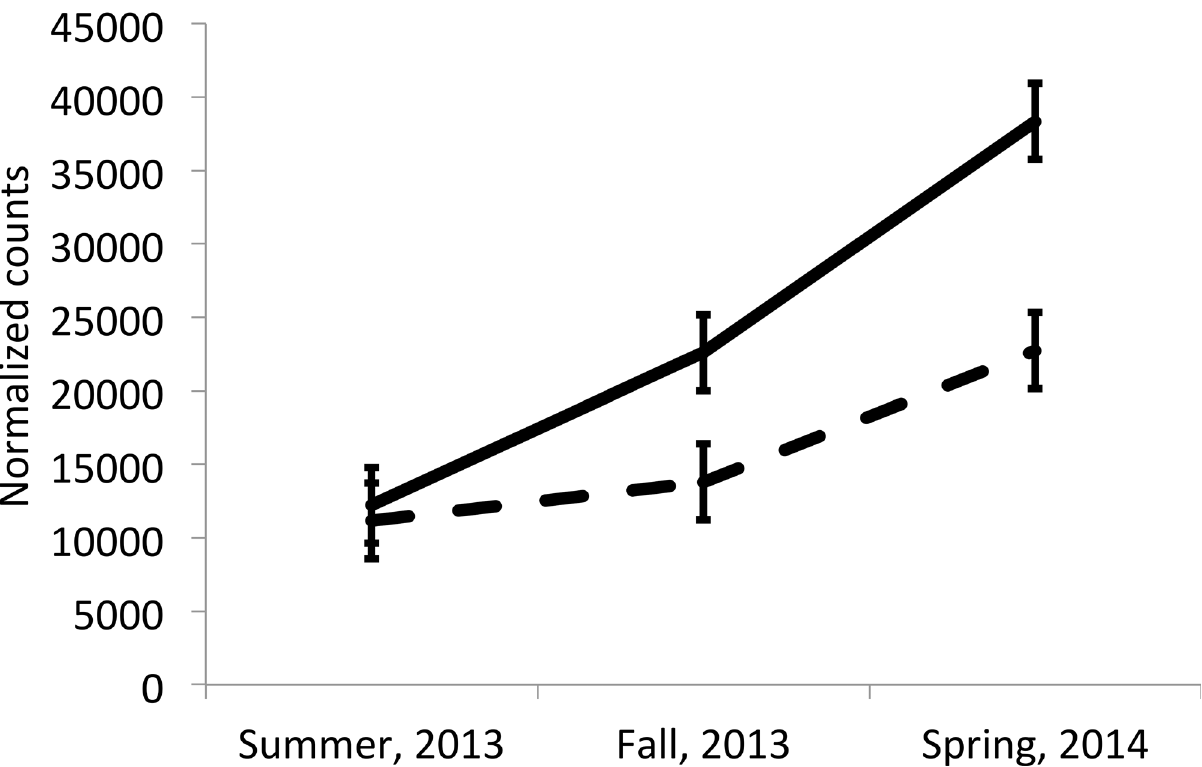
Fig 1. Interaction of season and antibody response to M . bovis for bta-miR-24-3p (P = 0.0268). Solid and dashed lines correspond to positive and negative groups, respectively.